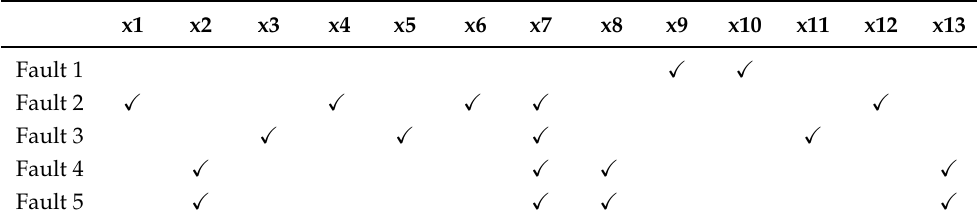
Table 4. Mapping features to their corresponding